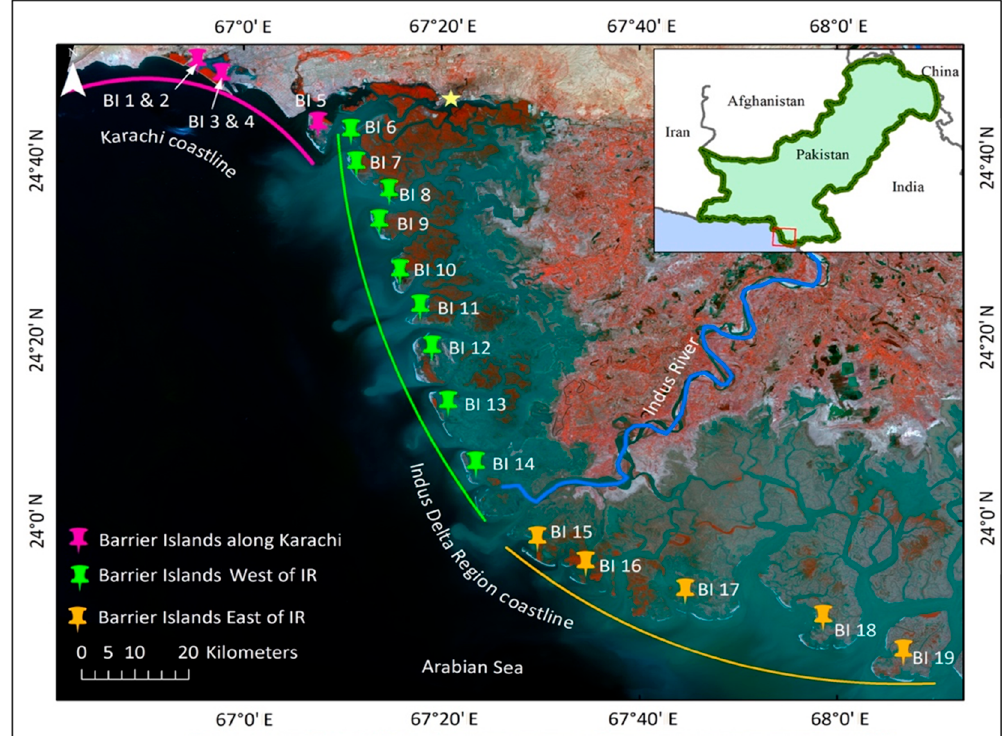
Figure 1. Location map of the study area’s barrier islands divided into two sectors: Karachi and the Indus Delta Region (IDR). Yellow star represents the location of tide gauge station. Inset in the upper right corner shows the geographical location of the Sindh Coast at the head of the Arabian Sea (red-colored rectangle). (Note: IR = Indus River).